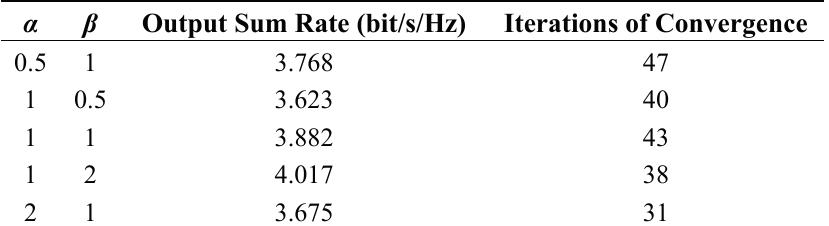
Table 2. The influence of the weight factors α and β